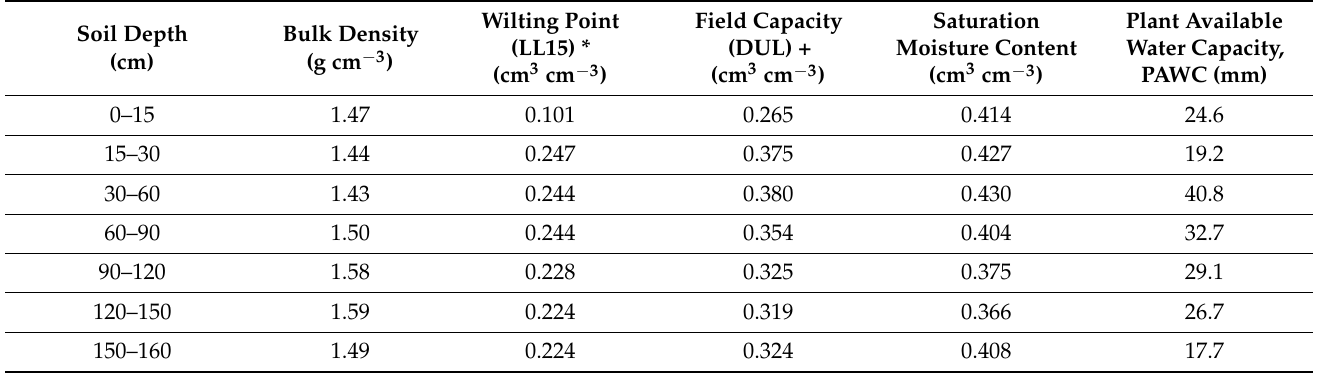
Table 1. Hydrologic properties of the Brown Chromosol soil in Murrumbidgee Irrigation Area, NSW Australia (http://www.apsim.info) (accessed on 4 August